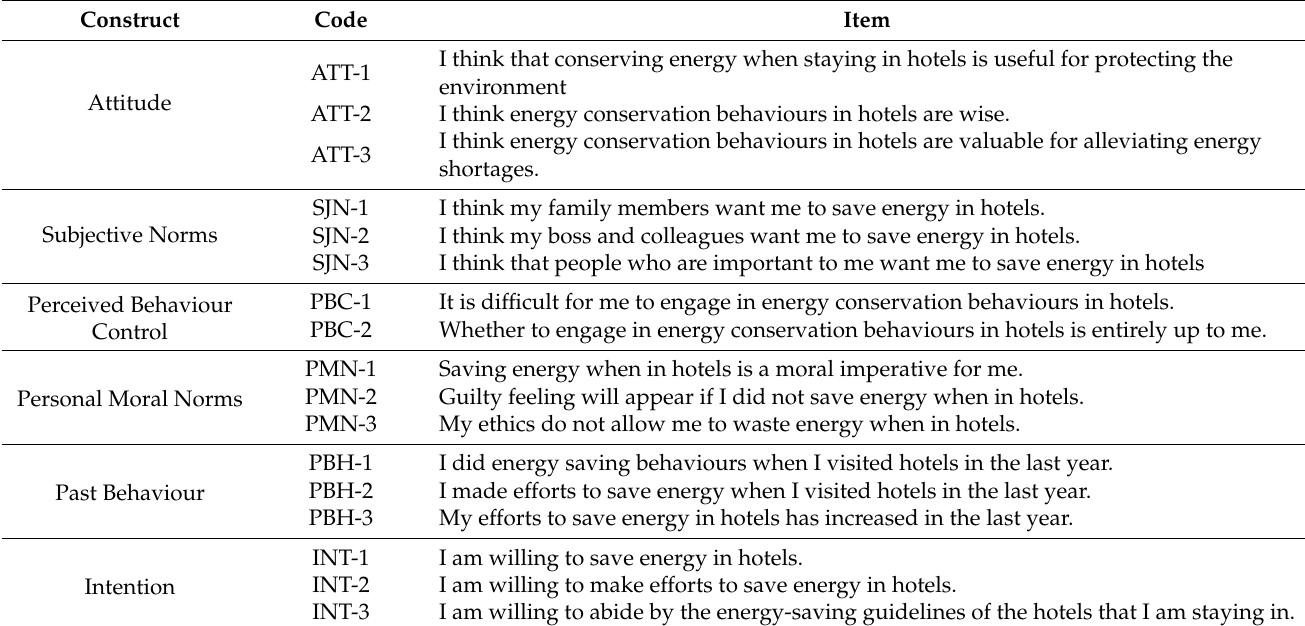
Table 1. Questionnaire design of Sections 1 and